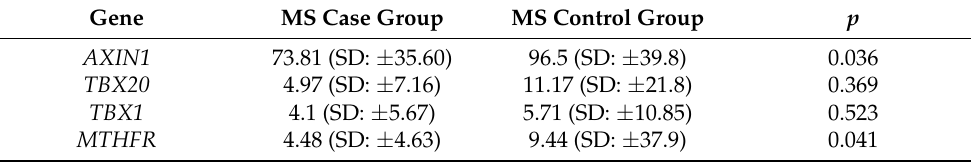
Table 3. Comparison of the MS of the four genes analyzed between controls and